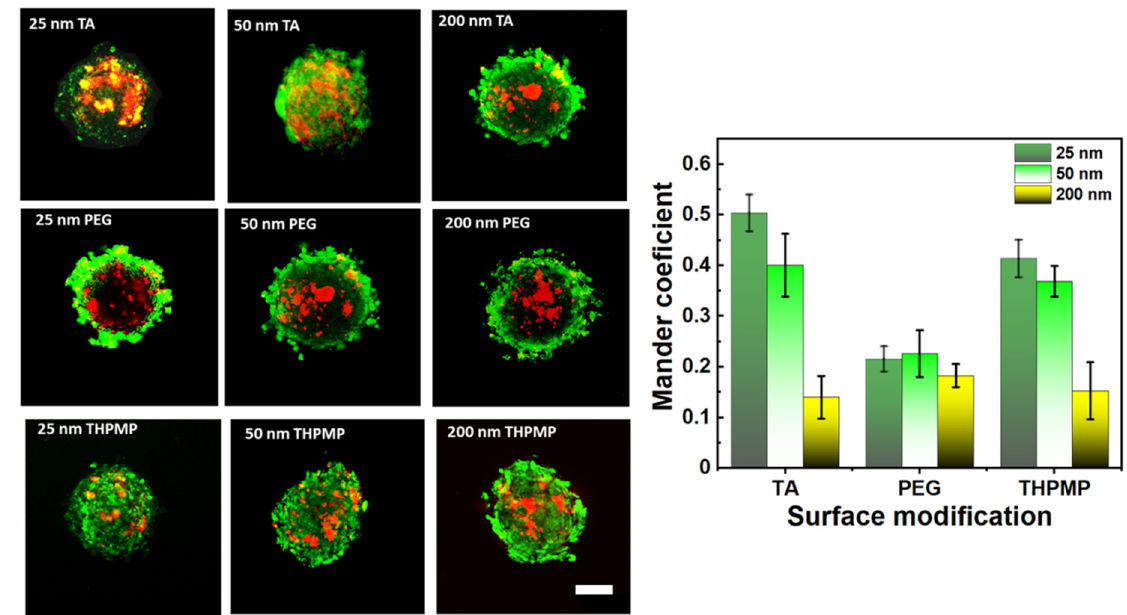
Figure 3. Two-photon images and distribution of MSNs (green) in the middle section of spheroids stained with Image-iT Red oxygen-sensitive reagent (red). Scale bar = 100 µm. N = 4.